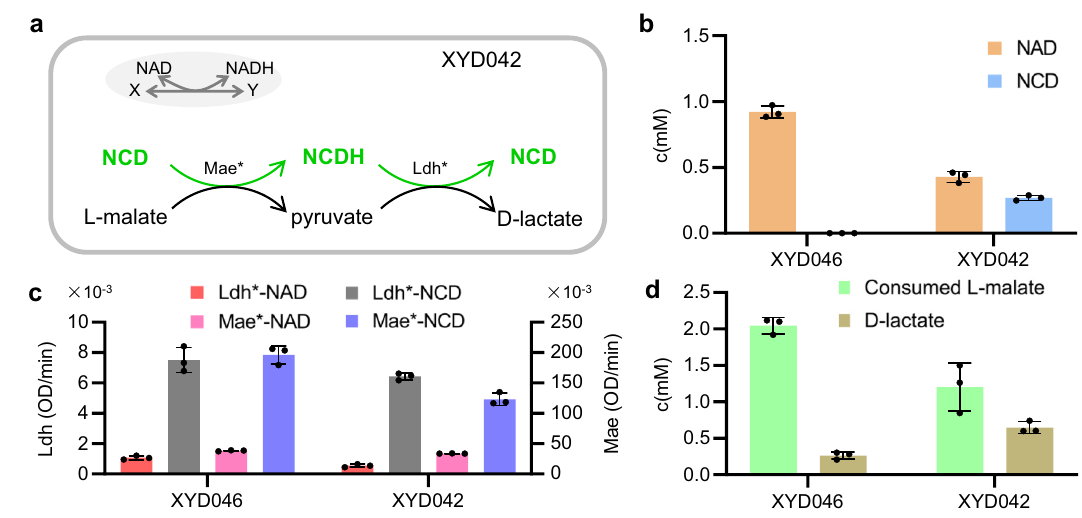
Fig. 5 Application of NCD self-suf fi cient cells. a NCD self-suf fi cient cells implanted with an NCD-linked metabolic circuit converting L-malate into D- lactate. b Intracellular cofactor concentrations. c Crude enzyme activities of Mae and Ldh with different cofactors. Ldh*-NAD assayed with NAD and D- lactate, Ldh*-NCD with NCD and D-lactate, Mae*-NAD with NAD and L-malate, Mae*-NCD with NCD and L-malate. d Pro fi les of L-malate consumption and D-lactate production. About 1.0 × 10 10 cells were incubated in MOPS buffer (pH 7.5) in the presence of 10 mM L-malate at 37 °C for 4 h. XYD042, BW25113 ( Δ ldhA, Δ dld , arsB::Para-FtNadE-c-his-NcdS-2-CtCTPS* )/pUC-Plac-Ldh*-rbs-Mae*; XYD046, BW25113 ( Δ ldhA, dld::cat )/pUC-Plac-Ldh*-rbs-Mae*. Data are presented as mean values± SD, error bars represent the standard deviation of data from three different cultures. The experiments were performed independently twice, with similar results. Source data are available in the Source Data fi